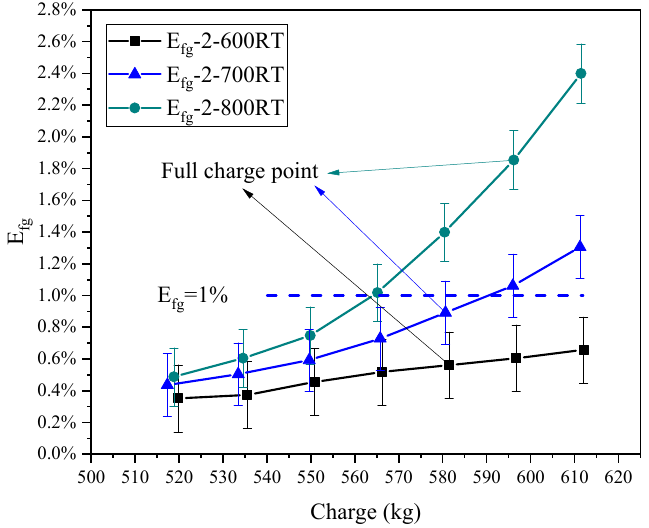
Figure 8. Liquid entrainment factor as a function of charge at each cooling capacity.